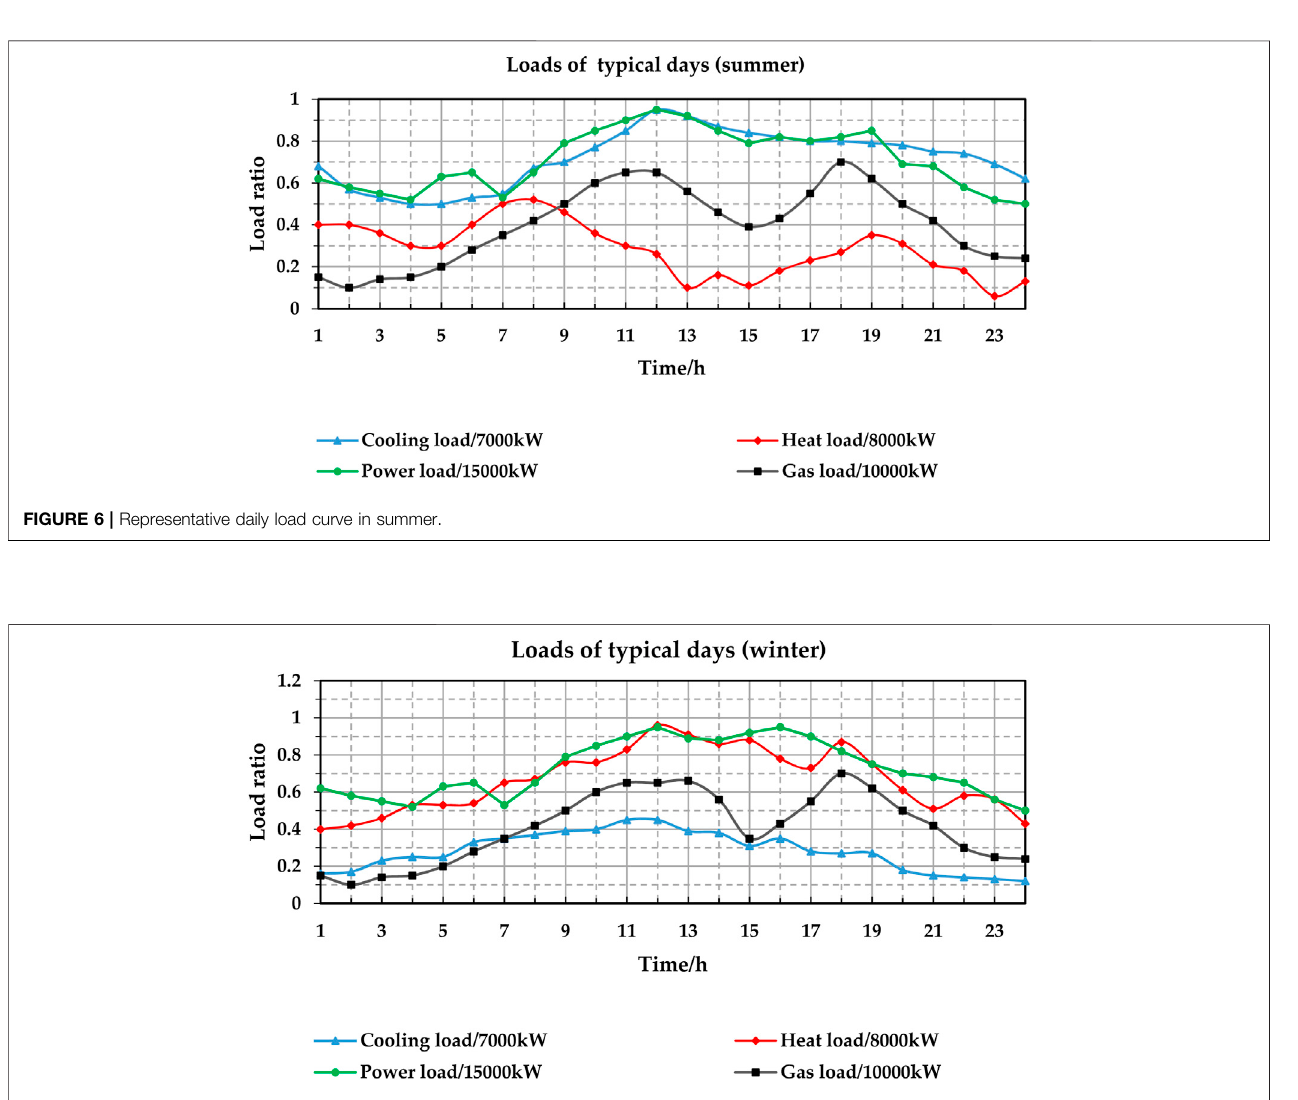
Frontiers in Energy Research |